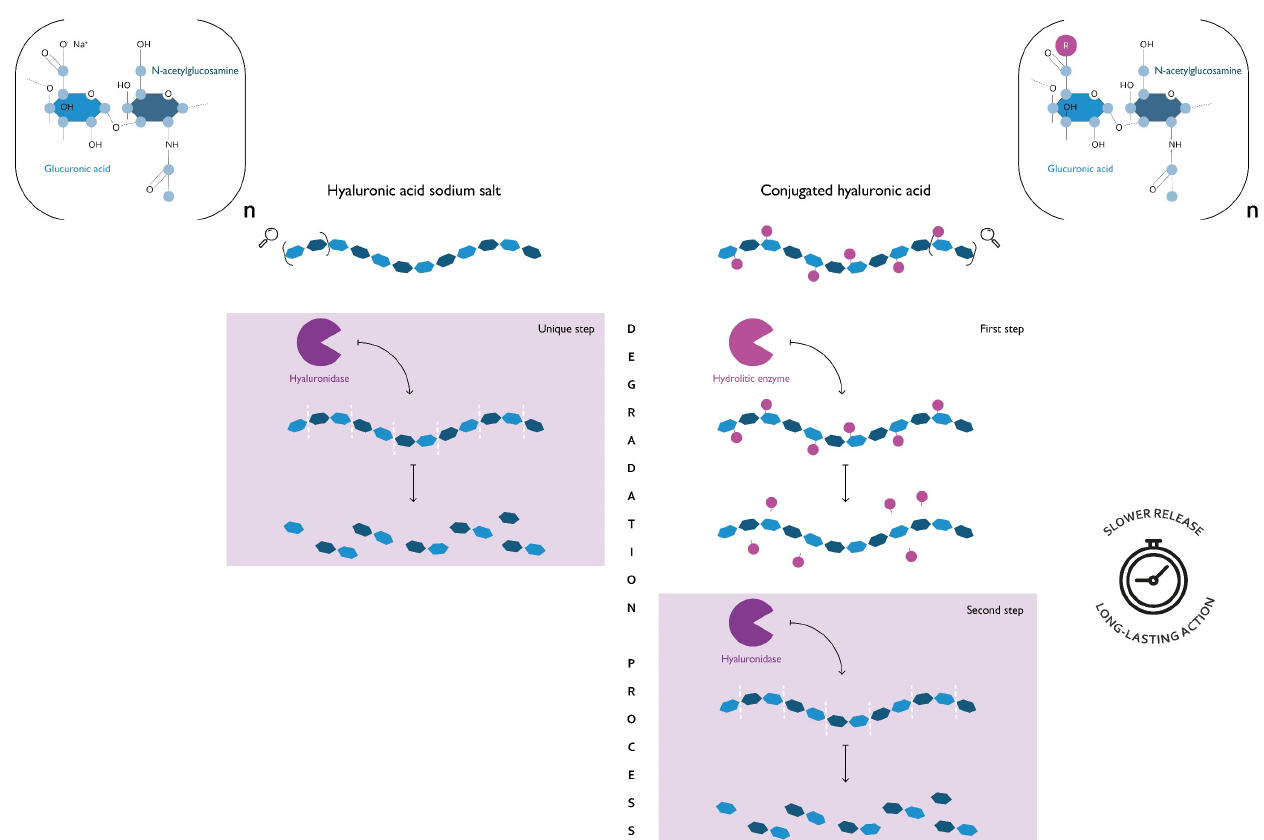
Figure 1. A comparison of the degradation process of hyaluronan and conjugated hyaluronic acid (HA). Both polymers are composed of a variable number of dimers (n dimers) of glucuronic acid and N-acetylglucosamine, linked via alternating β -1,4 and β -1,3 glycosidic bonds. Hyaluronan is the sodium salt of hyaluronic acid (HA) and represents the form that naturally occurs in the